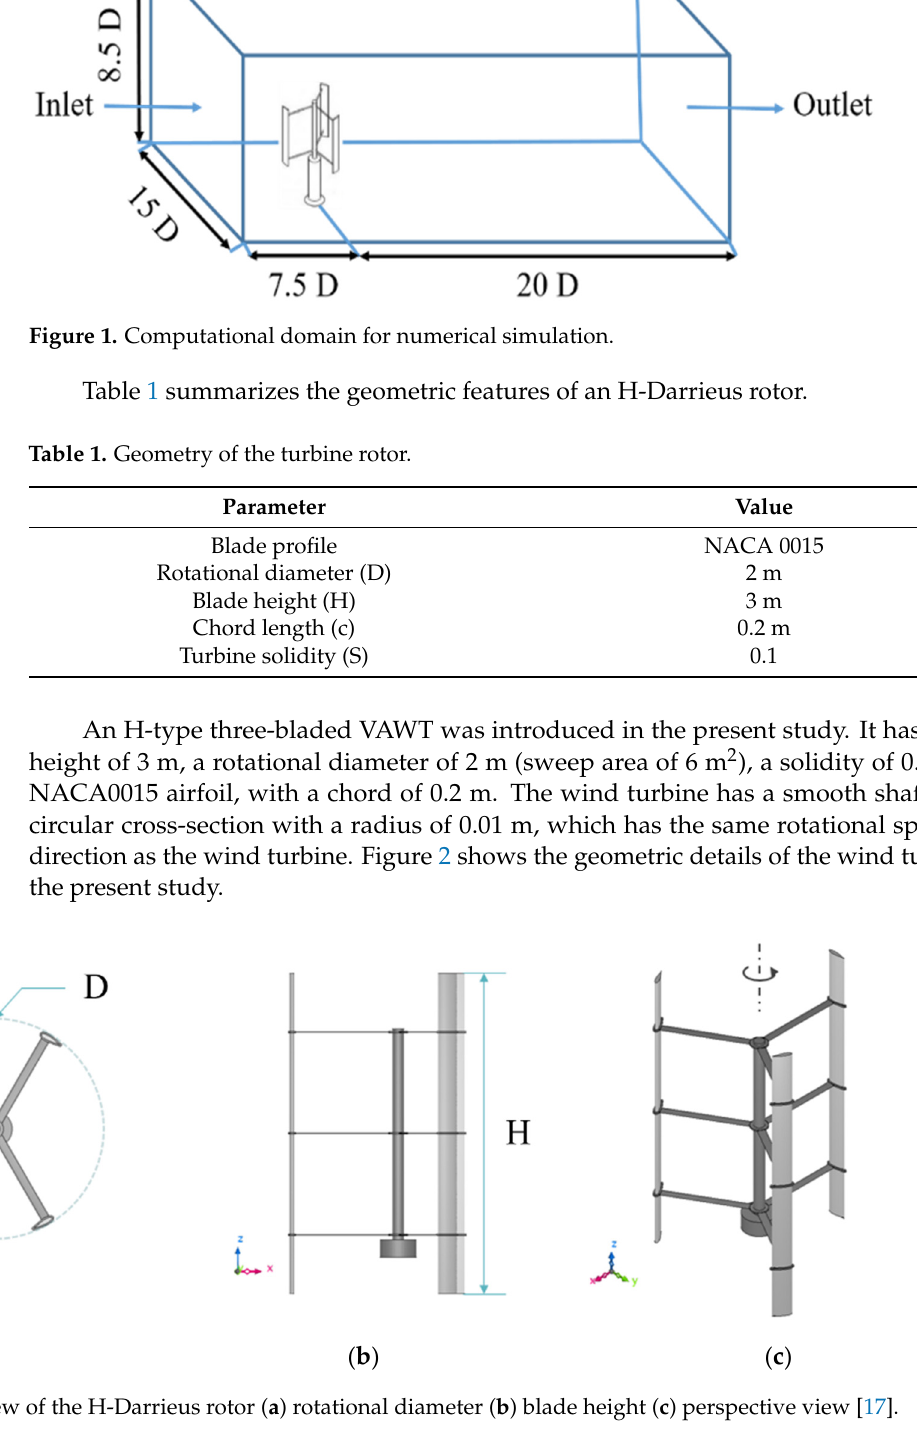
Figure 1. Computational domain for numerical simulation.